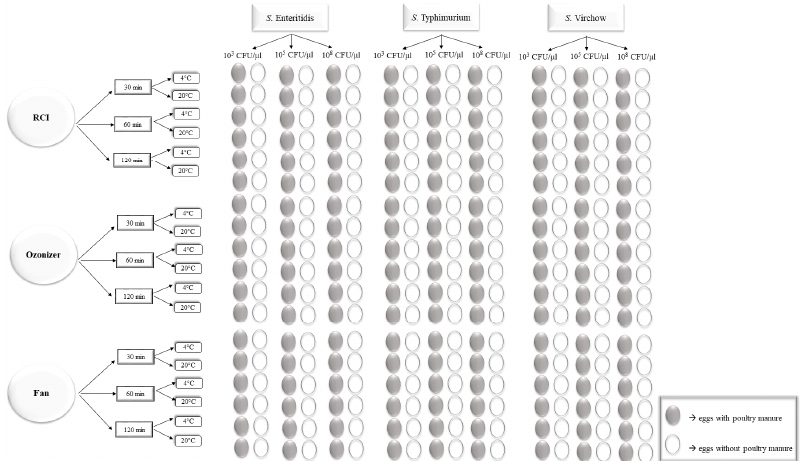
Figure 1. Scheme of experiment